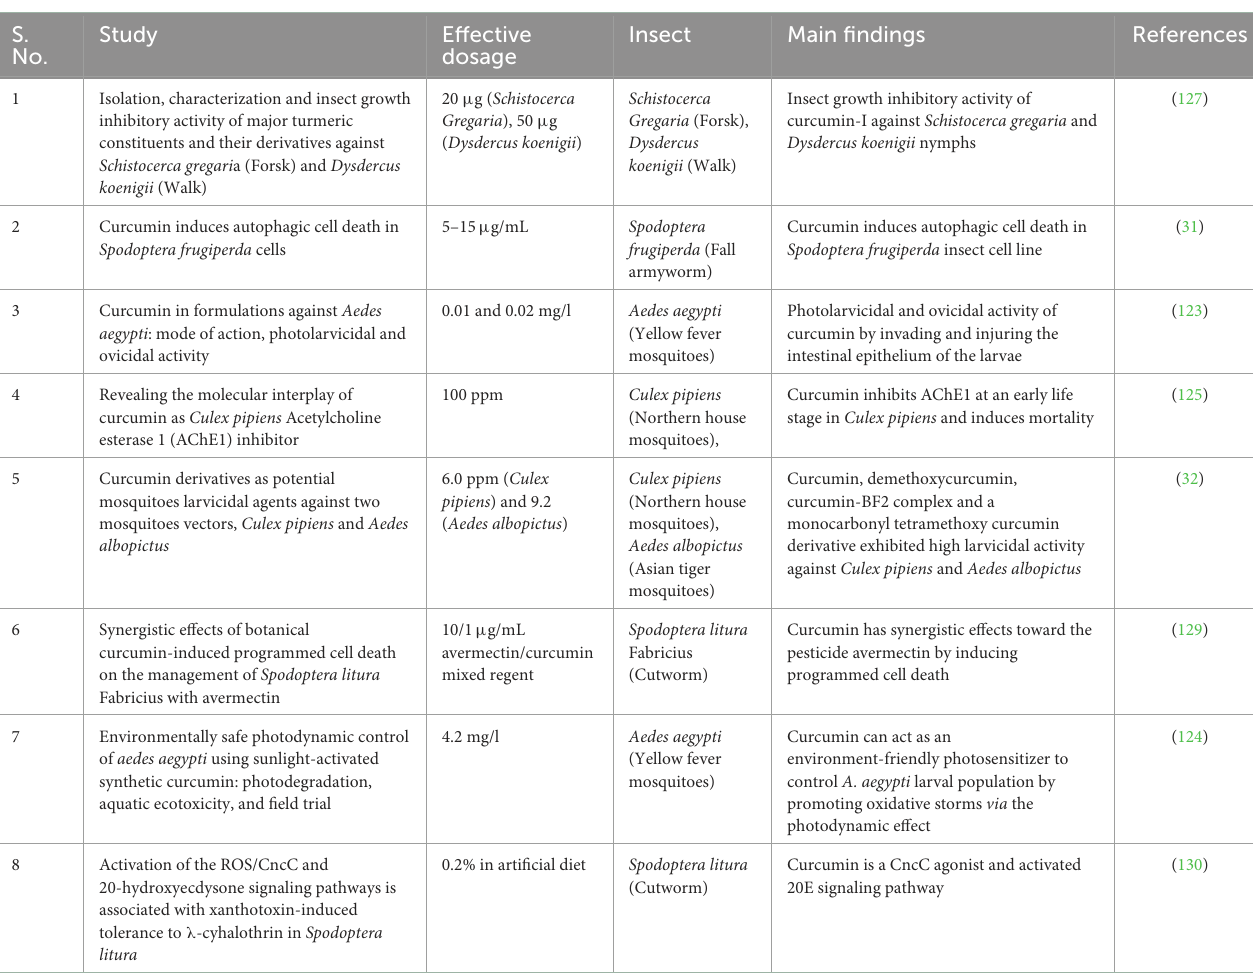
TABLE 3 Curcumin’s protective effect against different insect pests. S. No.